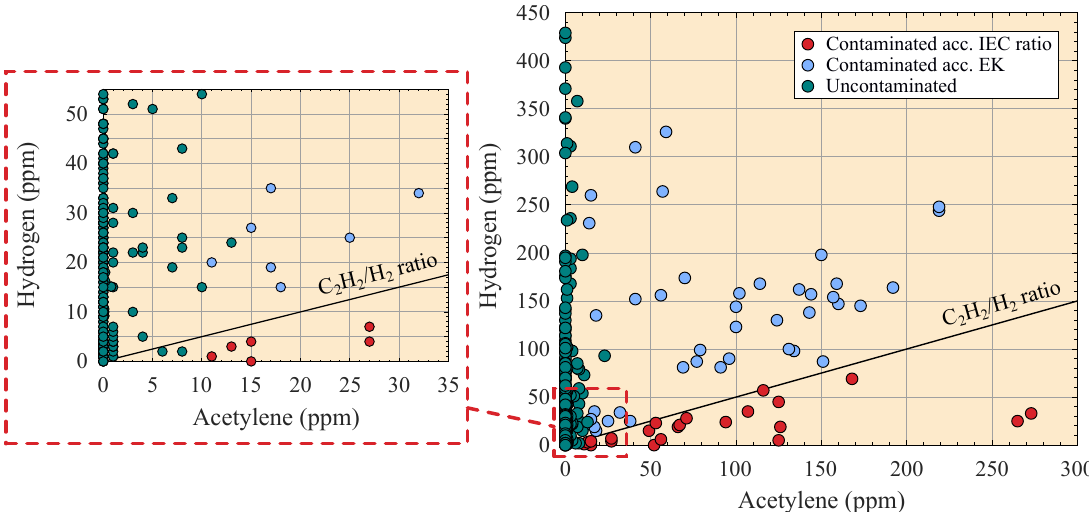
Figure 11. Responses used for algorithm